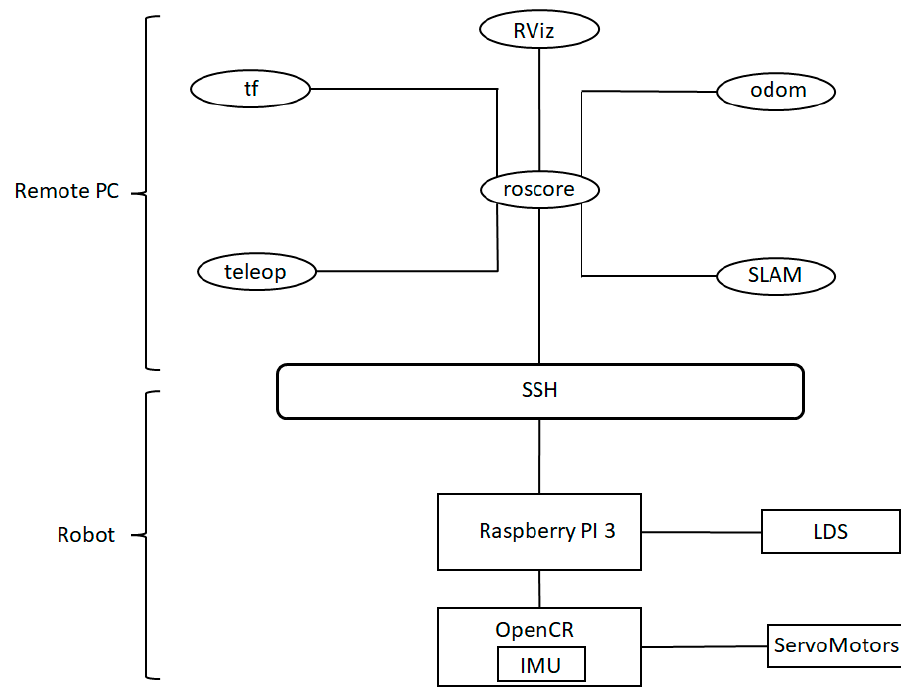
Figure 4. Setup of communication between the mobile robot and remote PC.